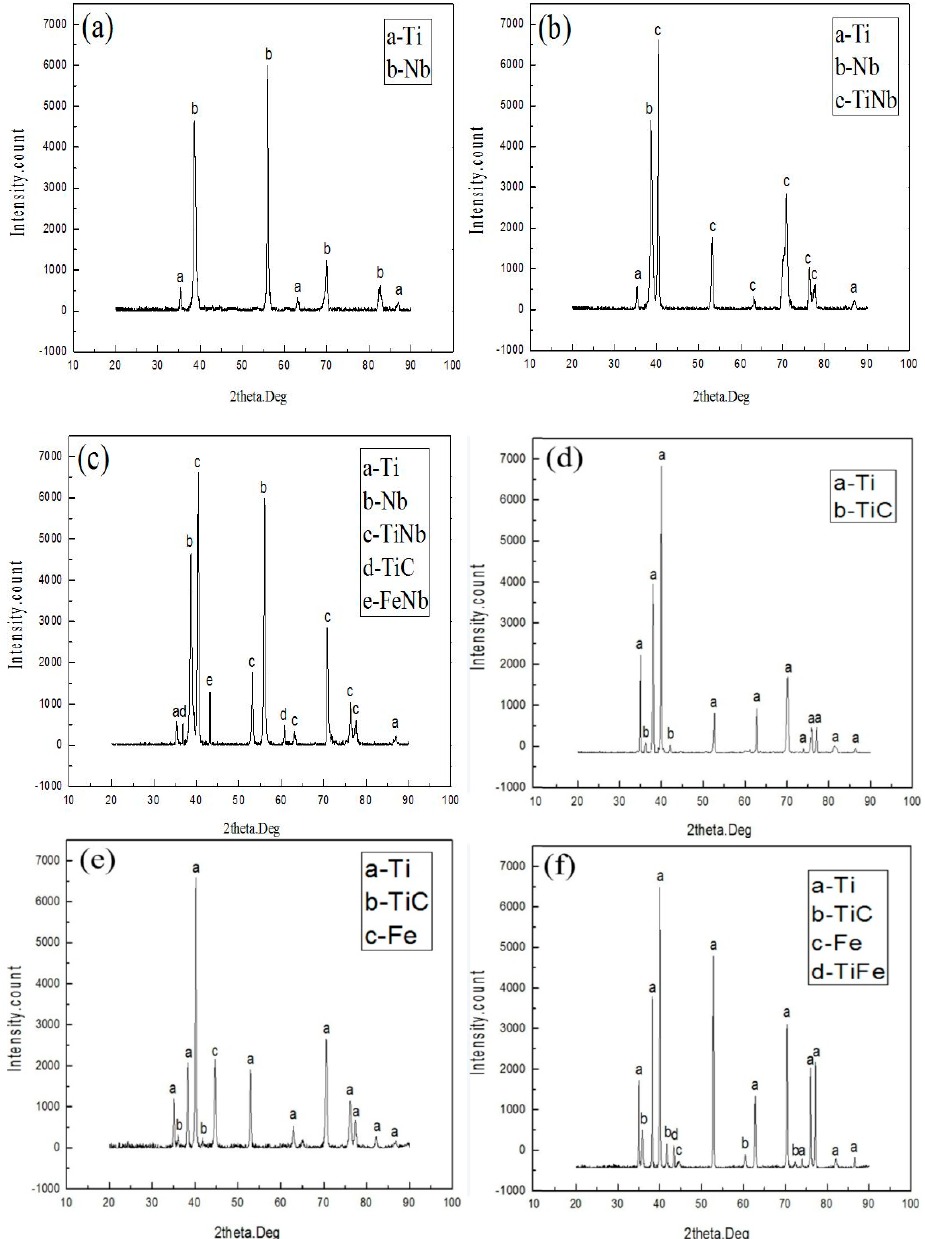
Figure 11. XRD results of the fractural surface at different heating temperatures (Ti side): ( a ) 800 °C; ( b ) 900 °C and ( c ) 1000 °C for Ti/Nb/steel clad plate; ( d ) 800 °C; ( e ) 900 °C and ( f ) 1000 °C for Ti/steel clad plate.